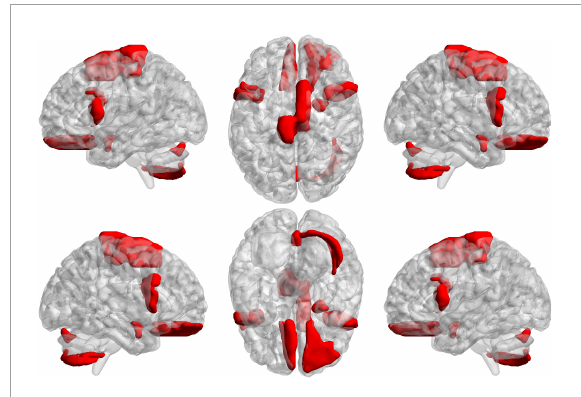
FIGURE9 The projections of ROIs corresponding to the ten time variability features with the large weights on the cortical surface.